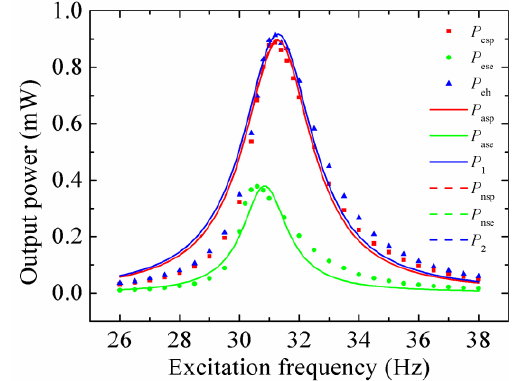
Figure 14. The optimal output power of the stand-alone PEH, stand-alone EMEH and HEH at different excitation frequencies.